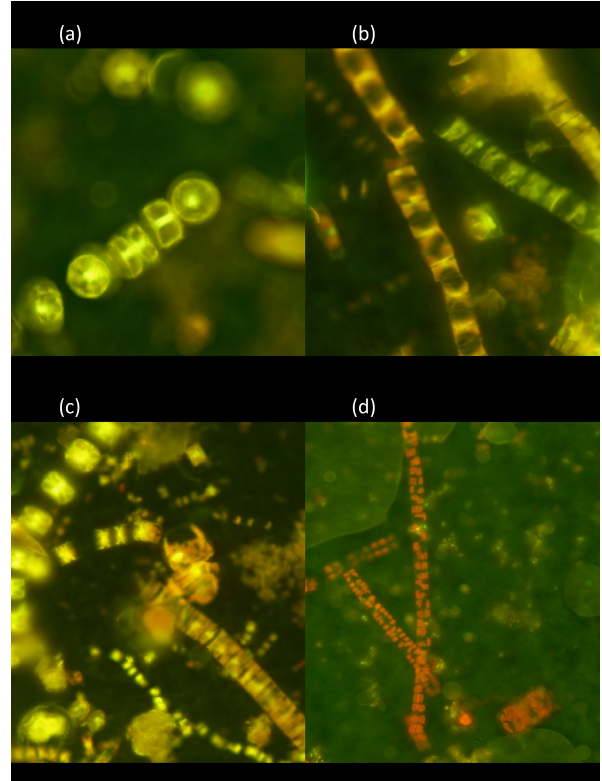
Figure 2. Photographs of the natural Arctic diatoms sampled with the Bottle-Net observed under epifluorescence microscopy and stained with the BacLight ™ kit. (a) Colonies of Thalassiosira spp. showing green fluorescence corresponding to living cells. (b) Colonies of Fragilariopsis spp. showing dead cells (red fluores- cence, vertical-left colonies) and living cells (green fluorescence, transversal-right colony). (c) Surface layer community, composed of multiple diatom genera ( Chaetoceros spp., Fragilariopsis spp., Thalassiosira spp., pennates), showing a blend of living cells (green fluorescence) and dead cells (red fluorescence). (d) Aphotic zone sample showing dead colonies (red fluorescence) of Fragilariopsis spp. and Thalassiosira spp. (two-cell colony in the bottom right of the